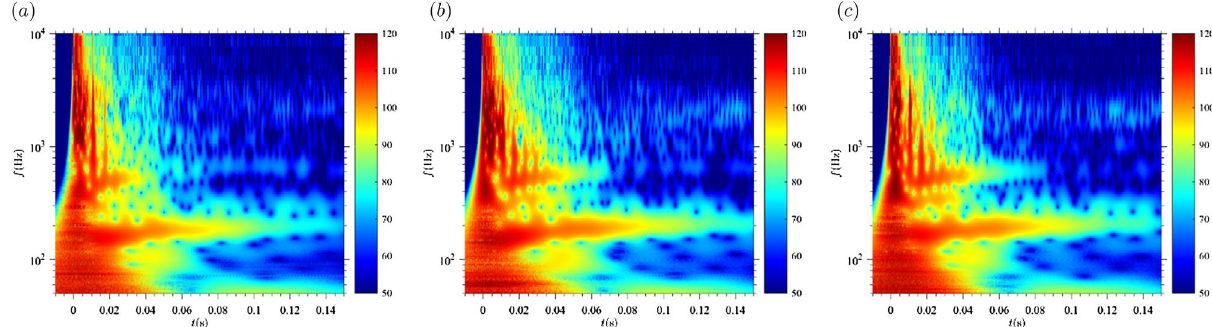
Figure 6. Effect of the nozzle geometry on the acoustic signature of the shock-tube in the wavelet diagram. The color scale represents the sound pressure level [dB] at the microphone location. L/D = 8 and p 0r /p ∞ = 50. ( a ) A e /A * = 1. ( b ) A e /A * = 2.36. ( c ) A e /A * =